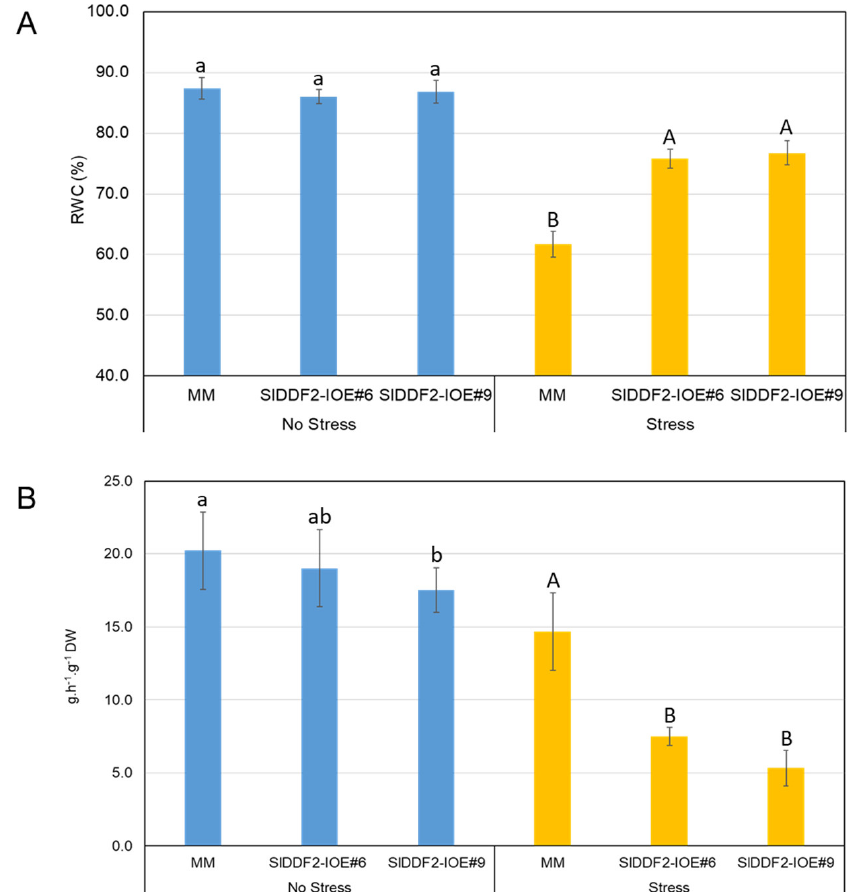
Figure 5. Relative water content of leaves of MM and SIDDF2-IOE#6 and SIDDF2-IOE#9 transgenic lines after 10 days of ( A ) water withholding and ( B ) water loss rate, as measured by decrease in fresh weight after two hours in detached leaves from MM and SIDDF2-IOE#6 and SIDDF2-IOE#9 transgenic plants. Values are the means ± SD. Different lower-case letters indicate a significant difference between transgenic and wild-type plants under nonstressed conditions, and different capital letters indicate a significant difference between transgenic and wild-type plants under stress conditions ( p < 0.05).